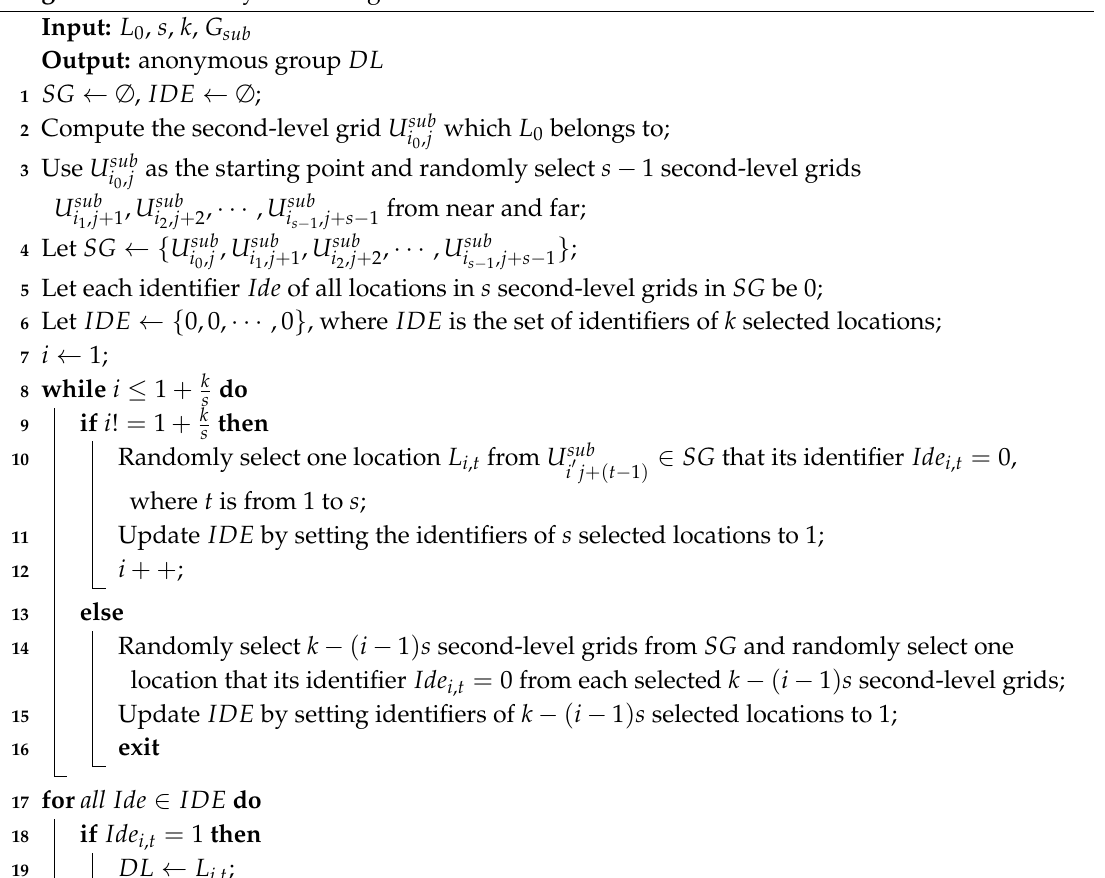
Algorithm 3: Dummy locations